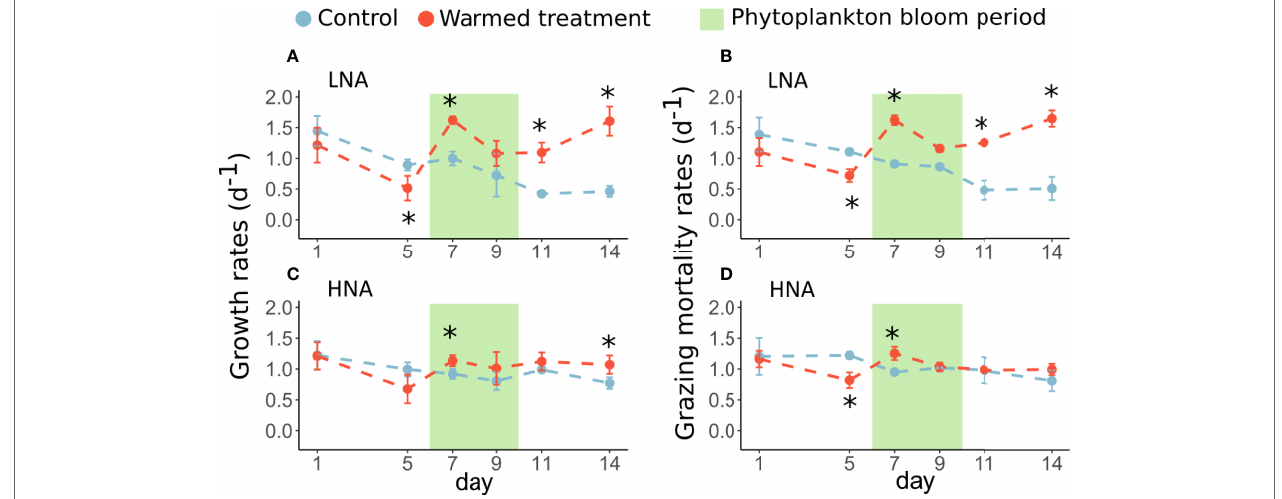
FIGURE 5 | Dynamics of the mean (± standard deviations) growth and grazing mortality rates of LNA (A, B) and HNA (C, D) groups in the control (blue) and warmed (red) treatments estimated from the dilution method. The error bars represent the standard deviations from the means. The stars (*) represent a significant difference ( p < 0.05) in the mean growth or grazing mortality rates between the control and warmed treatments. The green rectangle highlights the period of phytoplankton